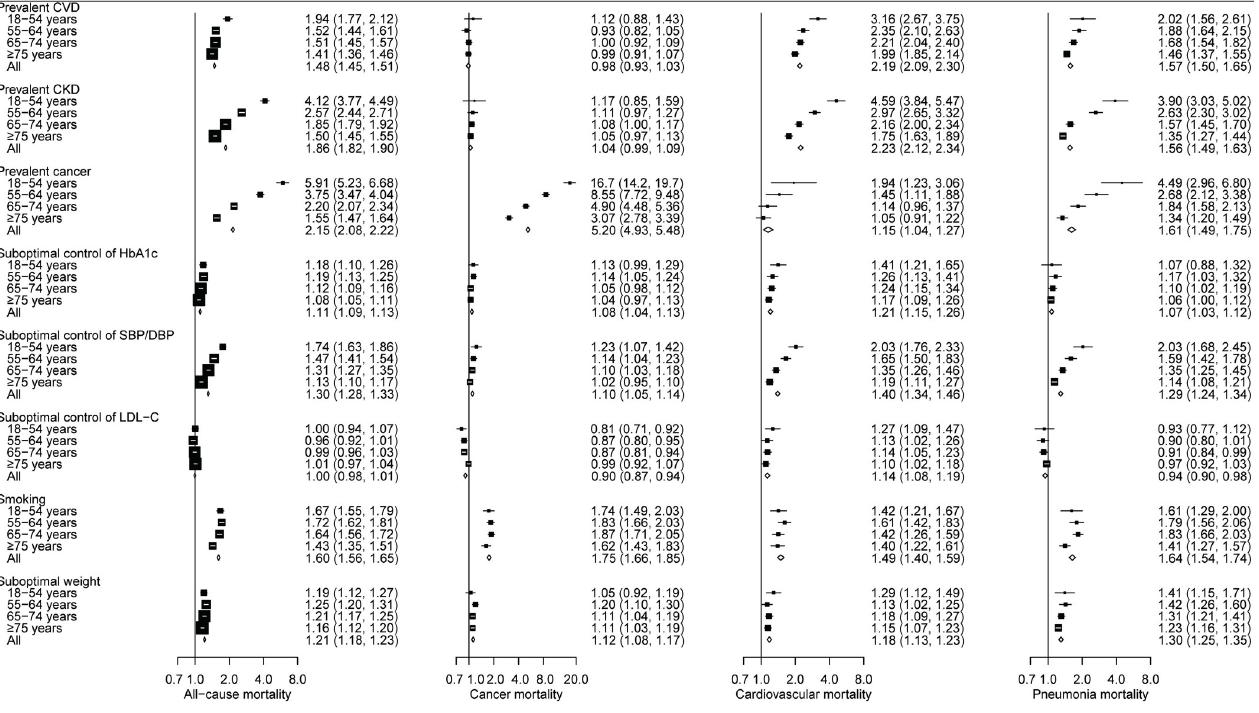
Fig 1. Age-specific HRs for the associations between risk factors and all-cause and selected cause-specific mortality in people with type 2 diabetes. The area of each square is inversely proportional to the variance of log HR, which also determines the 95% CI. CI, confidence interval; CKD, chronic kidney disease; CVD, cardiovascular disease; DBP, diastolic blood pressure; HbA1c, haemoglobin A1c; HR, hazard ratio; LDL-C, low-density lipoprotein cholesterol; SBP, systolic blood pressure.